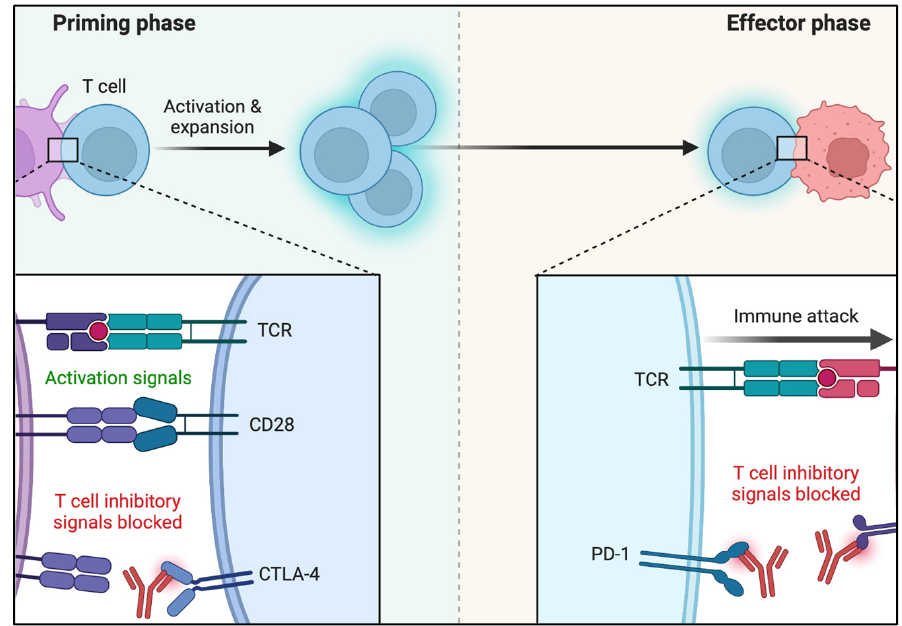
Figure 1. Molecular mechanisms of CTLA-4 and PD-1 inhibitory T-cell activation. Reprinted from “Blockade of CTLA-4 or PD-1 Signaling in Tumor Immunotherapy”, by BioRender.com (2022) (ac- cessed on 6 March 2022). Retrieved from https://app.biorender.com/biorender-templates (accessed on 6 March 2022).